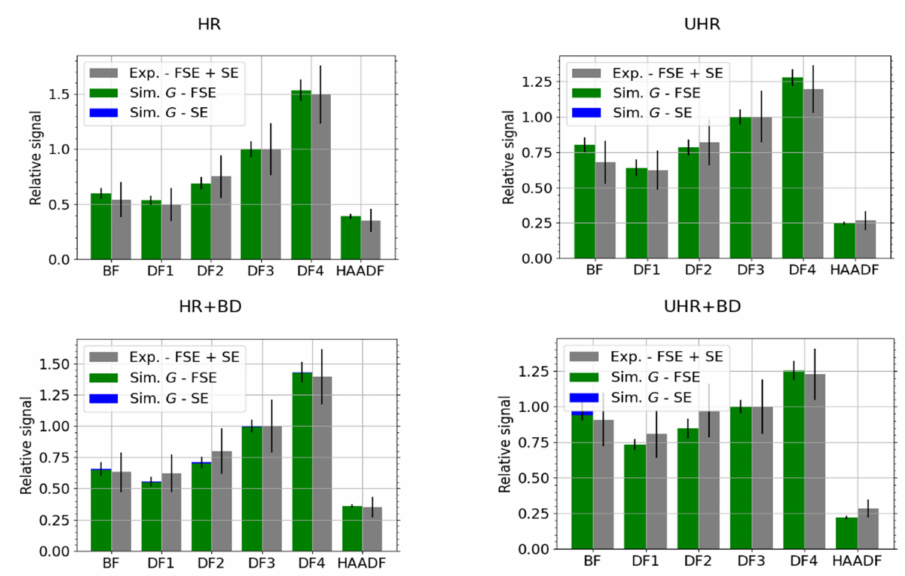
Figure 5. C—comparison of simulated and experimental data for HR, HR + BD, UHR and UHR + BD microscope modes, E L = 15 keV. The data have been scaled to the segment DF3. Simulation data are split into secondary electrons (SEs) and forescattered electrons